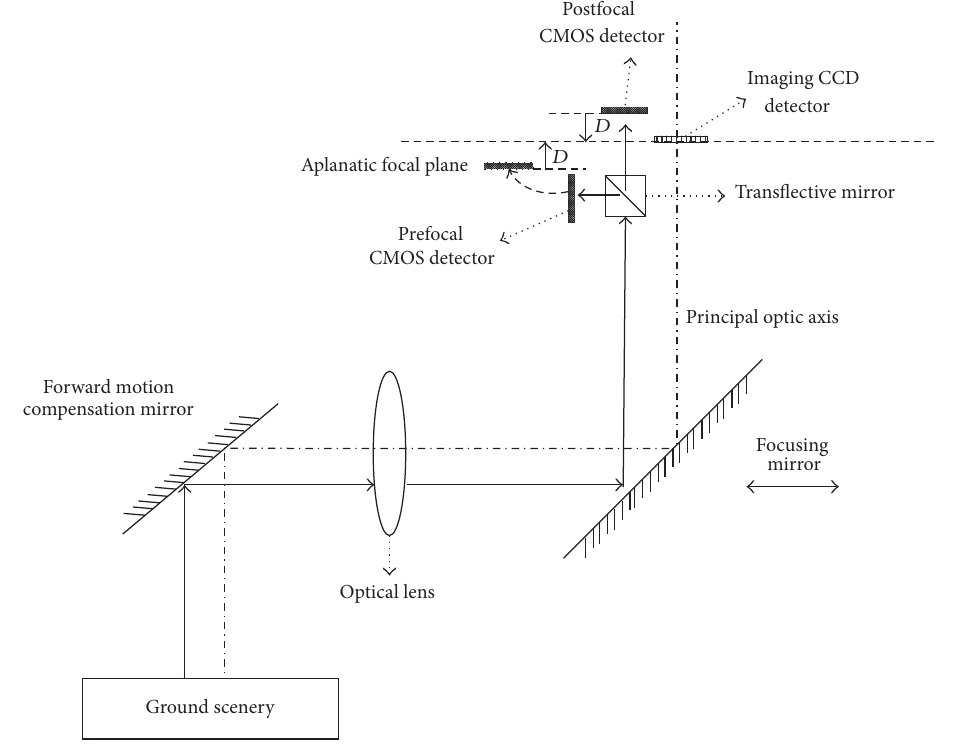
Figure 6: Optical-mechanical structure of autofocusing